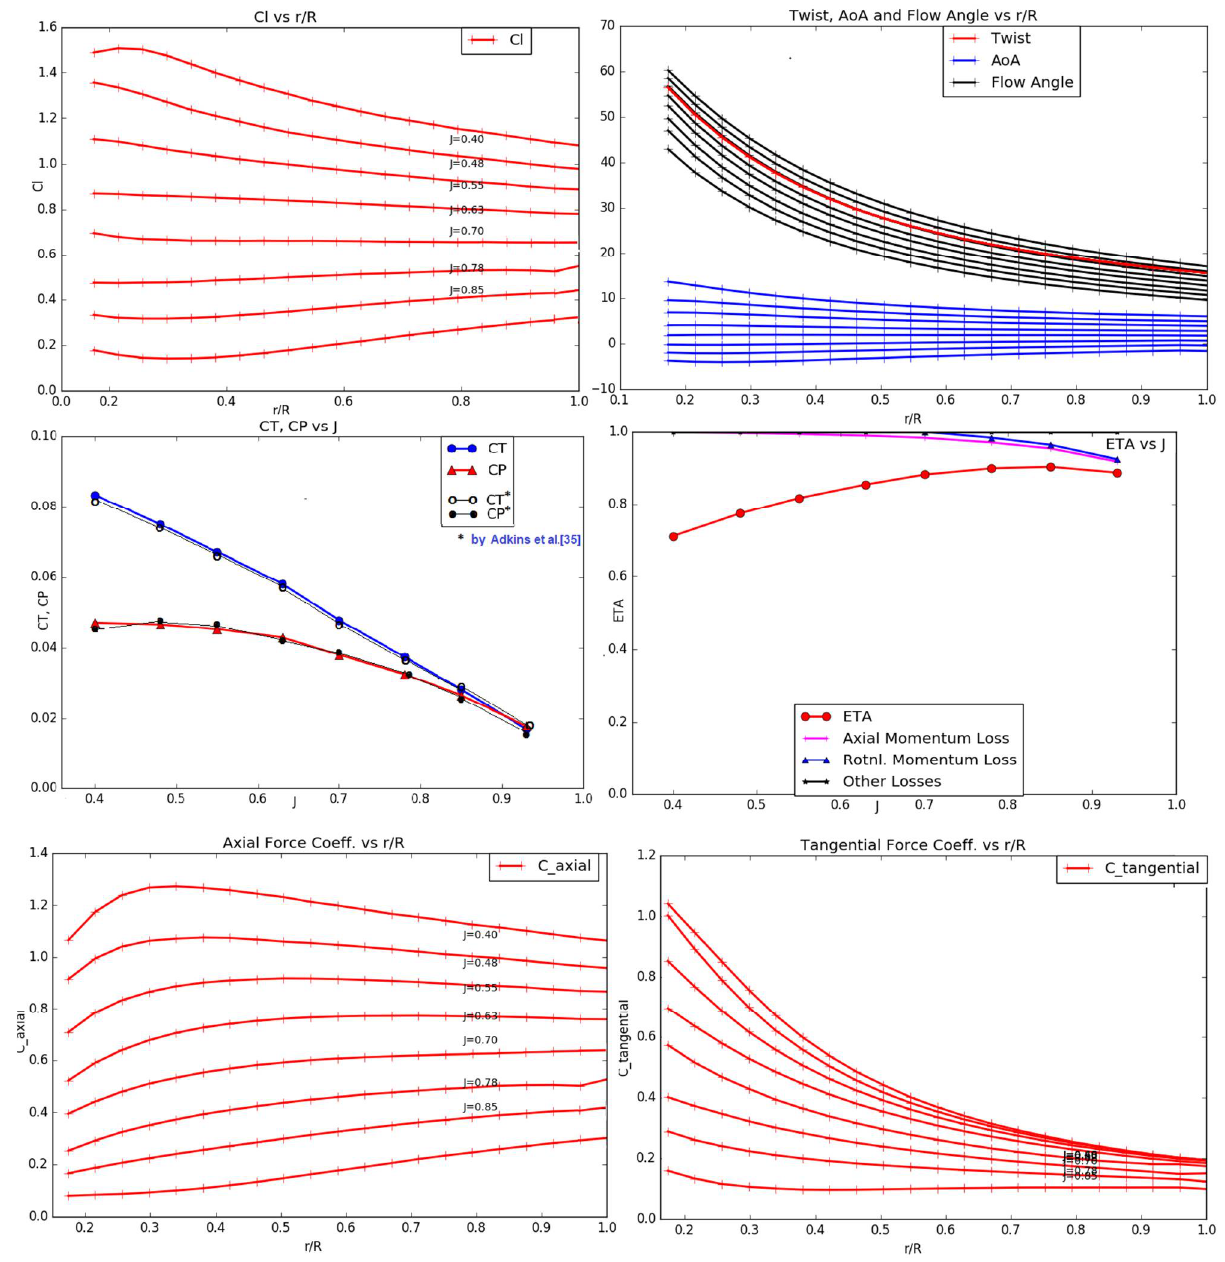
Figure 8. Spanwise aerodynamic properties of the light aircraft solo propeller at several off-design operating points analyzed using py_BEM.